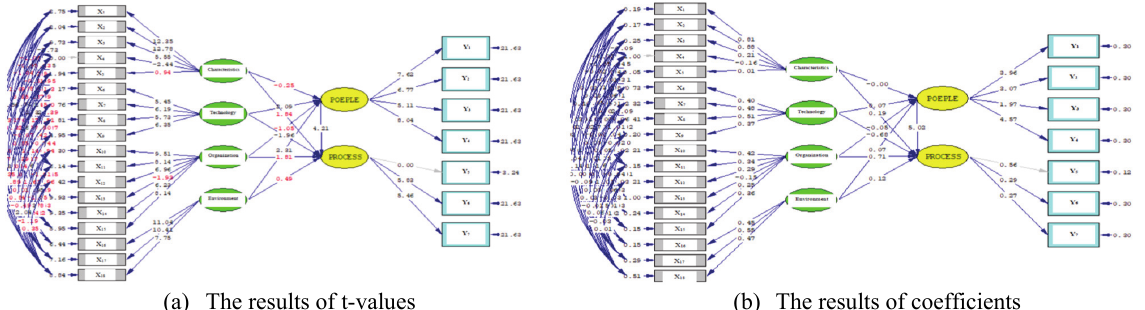
Fig. 1. Model of innovation marketing